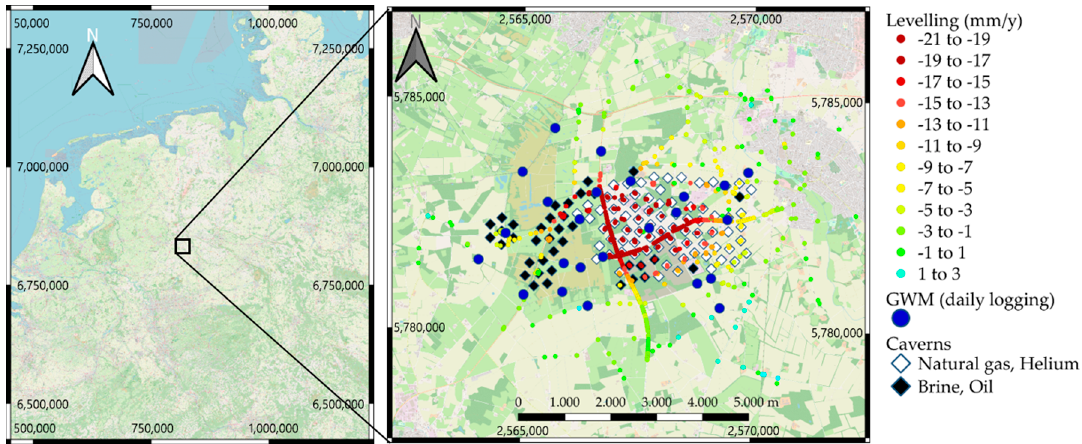
Figure 1. Locations of levelling measurements (markers colored according to linear trends), ground water measurements (GWM) with daily logging and of caverns. The background map is from Open Street Map.